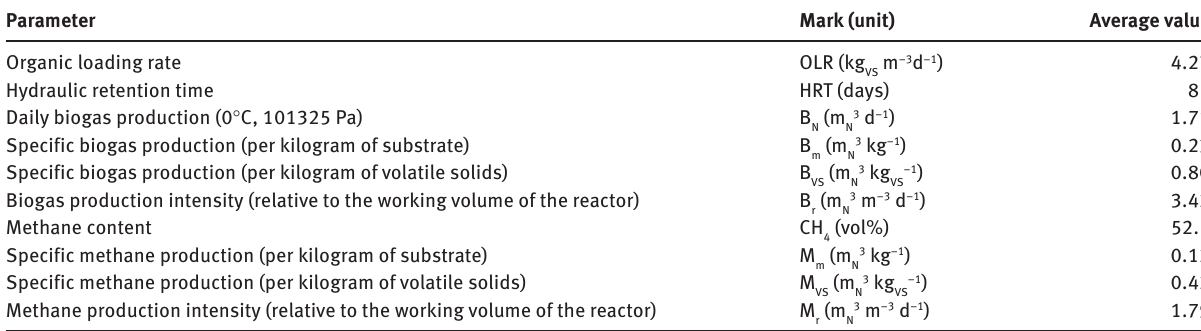
Table 3: Average process parameters. Parameter Mark (unit) Average value Organic loading